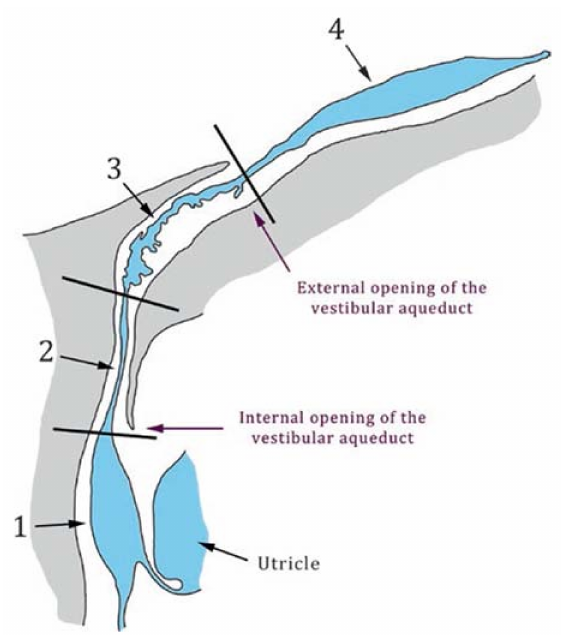
Figure 1. Schematic drawing of the vestibular aqueduct and the endolymphatic duct and sac. The vestibular aqueduct is a bony canal located into the temporal bone (grey) and is delimited by its medial (internal) and external apertures. The endolymphatic duct and sac (blue) are membranous structures that lie within the vestibular aqueduct and comprise the sinus (1), the isthmus (2), a rugose (3), and a smooth portion (4). Black lines indicate the limits between the different portions of the endolymphatic duct and sac. Taken from [16], with permission from Springer International Publishing,